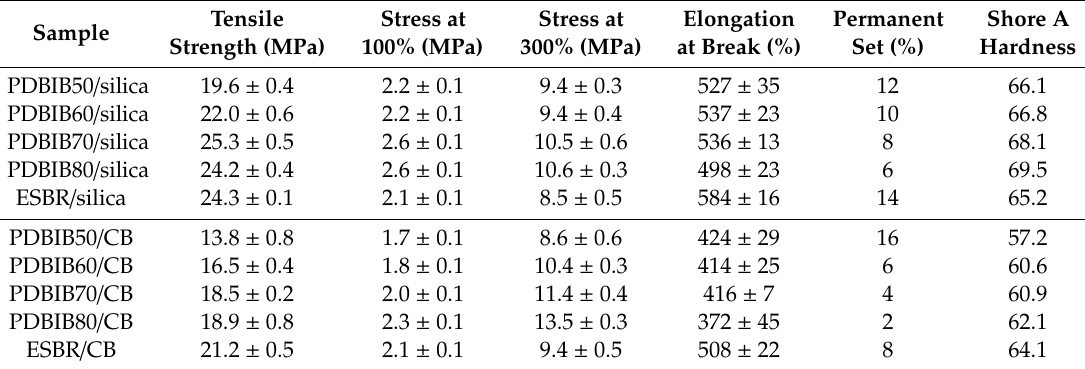
Table 7. Mechanical performance of the PDBIB and ESBR nanocomposites.